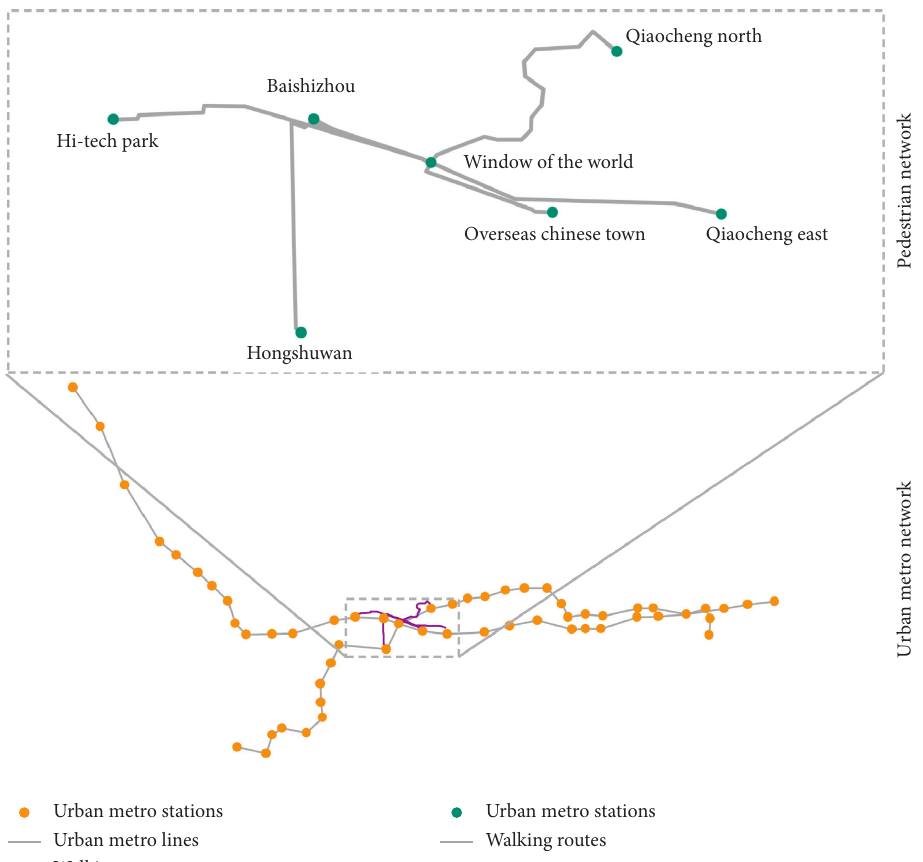
Figure 5: The two-layer network. The bottom diagram shows the urban metro network, and the top diagram shows the pedestrian network between six alternative stations and the crowding station.